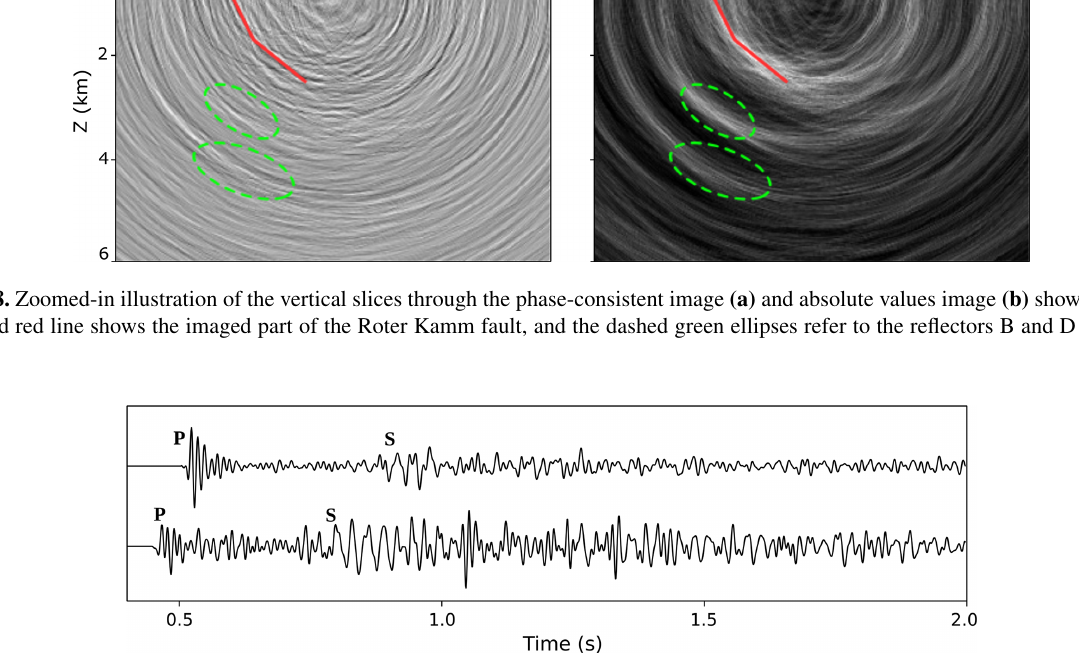
Figure 9. An example of the recorded waveforms used in the migration procedure. The P and S direct waves are marked for comparing the frequency